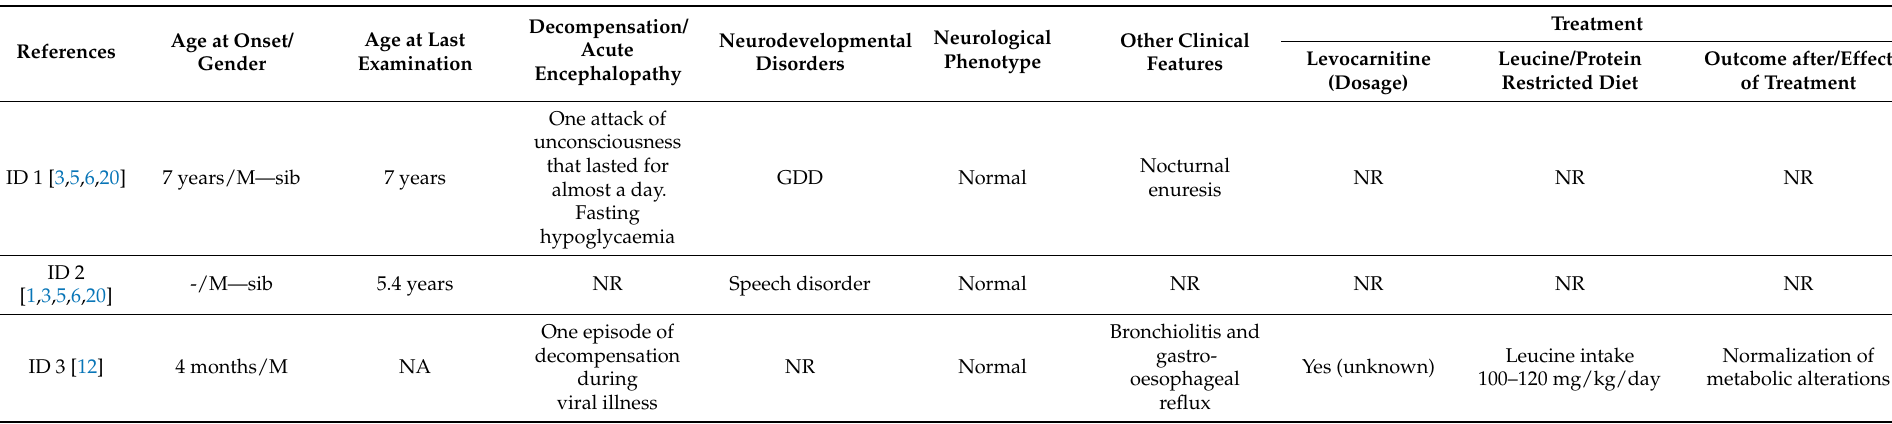
Table 2. Clinical data on all AUH -deficient patients reported in the